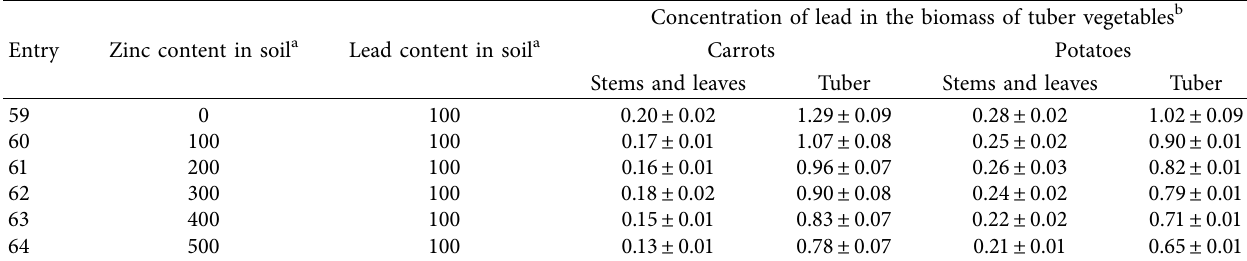
Table 10: Effect of zinc on the accumulation of lead from soil to tuber vegetables.